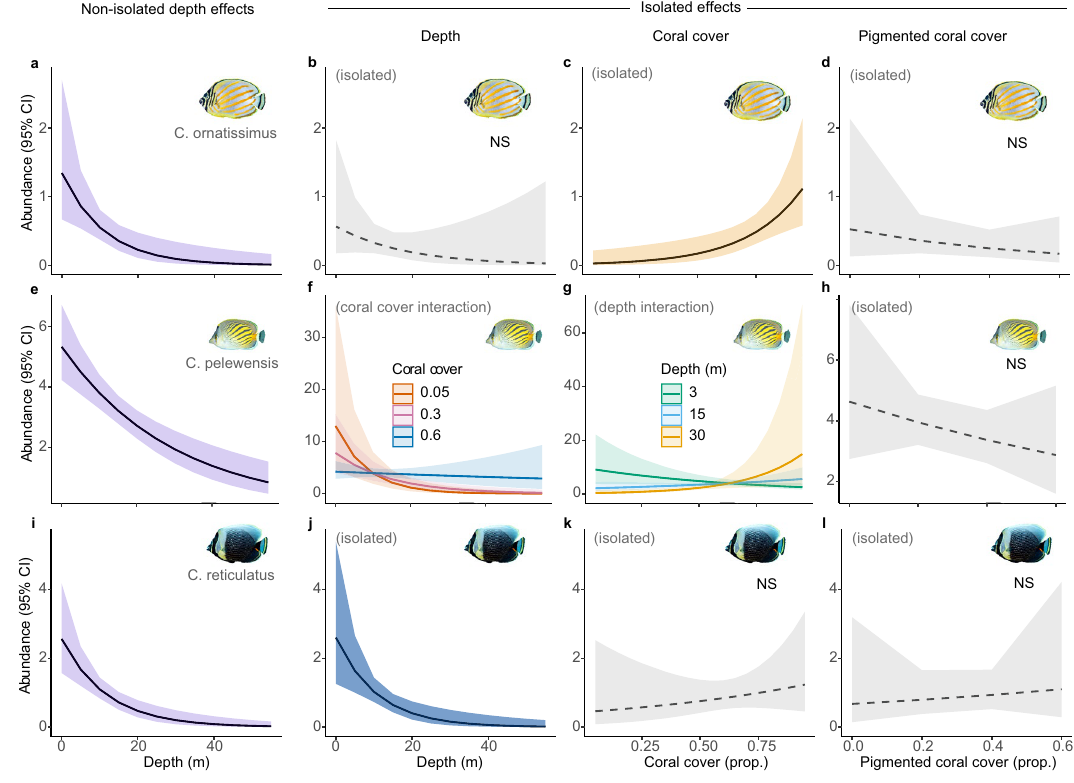
Figure 2. The distributions of three obligate coral feeding butterflyfishes (aligned in rows) in relation the combined and isolated effects of water depth (0–50 m), total coral cover (0–80%) and pigmented coral cover (0–60%). The left column ( a , e , i ) shows butterflyfish densities along the depth gradient, without conditioning for the effects of coral cover and pigmented corals. The second column ( b , f,j ) shows butterflyfish density along the same depth gradient, after conditioning for the effects of coral cover gradients. In this column, ( f ) shows a significant interaction between depth and total coral cover (i.e., regardless of bleaching condition), with the later held constant at 5% (red), 30% (pink), and 60% (blue). The third column ( c , g,k ) shows the effects of total coral cover isolated from depth and pigmented coral cover. In this column, ( g ) shows an interaction with depth held constant at shallow (3 m — green), intermediate (15 m — blue) and upper mesophotic (30 m — orange) depths. The final column ( d , h,l ) shows the effects of pigmented coral cover after conditioning on coral cover and depth effects. NS signifies non-supported hypotheses, which are further highlighted with dashed mean-effect lines and greyed-out confidence intervals. See Supplemental Fig. S7 for more information about conditioning on covariates to isolate main